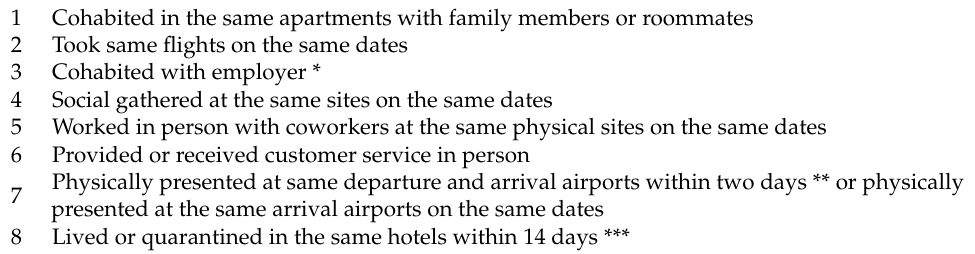
Table 2. Eight Scenarios for Edges